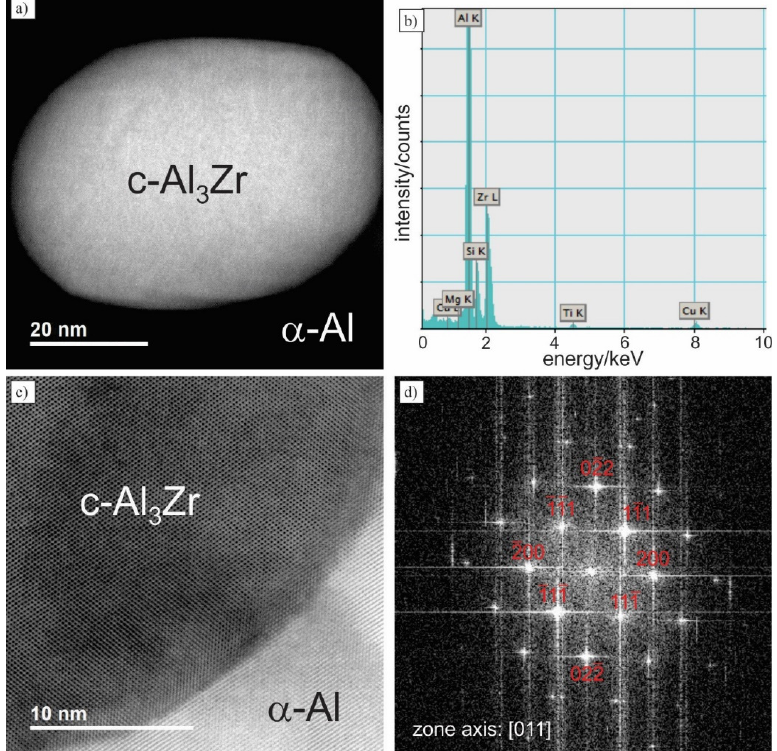
Figure 11. An c-Al 3 Zr dispersoid in the alloy after T6 temper. ( a ) HAADF micrograph, ( b ) EDS-